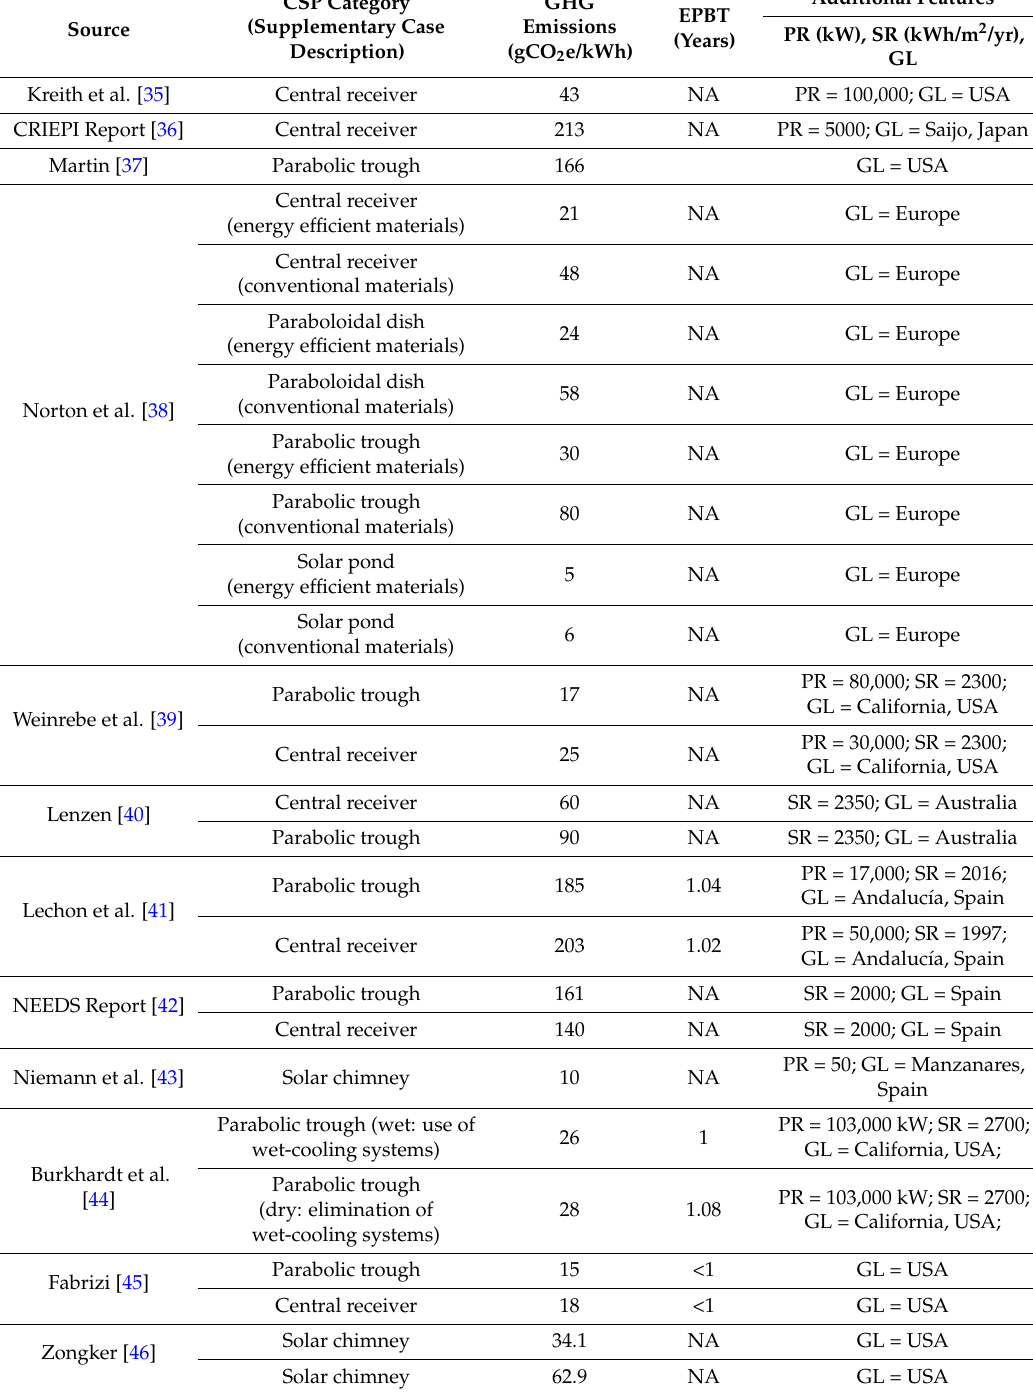
Table 2. GHG emissions and EPBT periods for CSP electricity generation